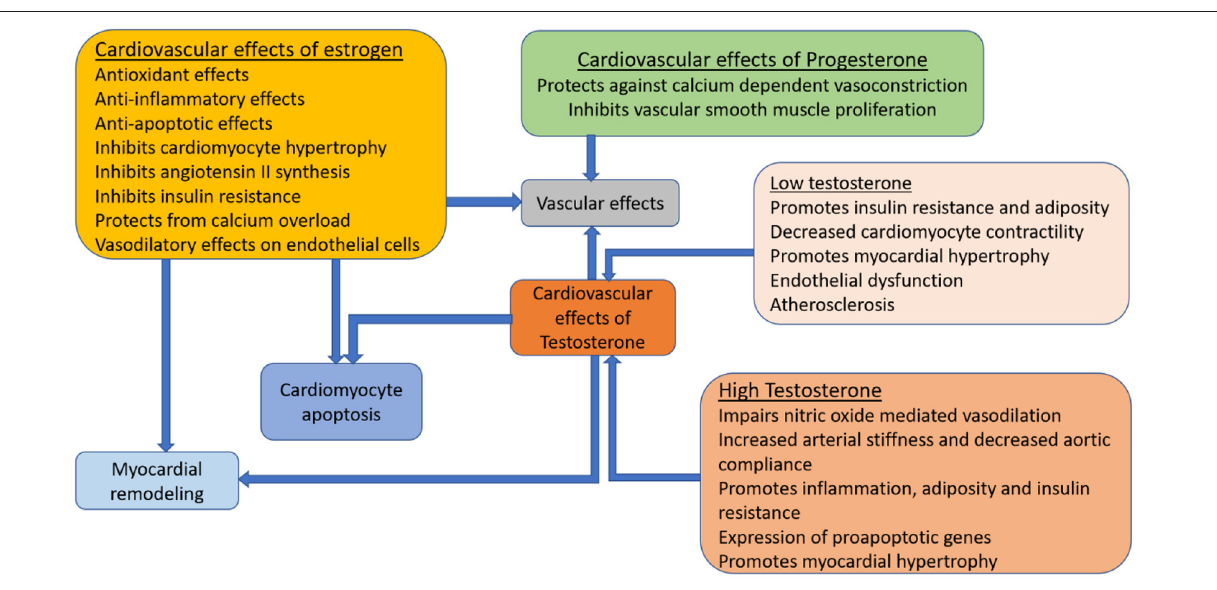
FIGURE 1 | Influence of sex-steroid hormones on the cardiovascular system. Cardiomyocytes and vasculature have receptors for major female sex-steroid hormones; estrogen, progesterone and testosterone. These sex-steroid hormones influence heart failure progression through cellular mechanistic processes that have direct and indirect effects on the myocardium and vascular